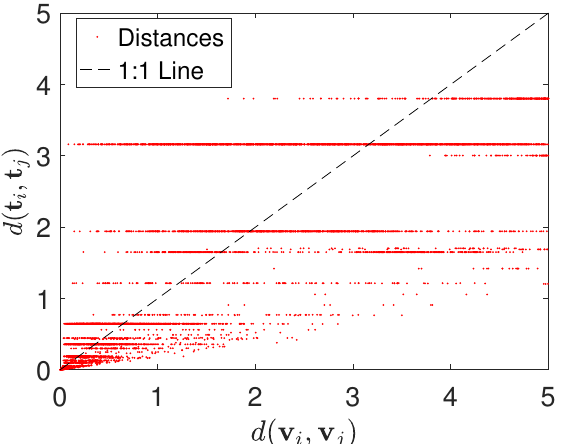
Figure 3. Shepard plot for the HC cophenetic distances obtained with d 6 . The cophenetic correlation coefficient is cc = 0.89.